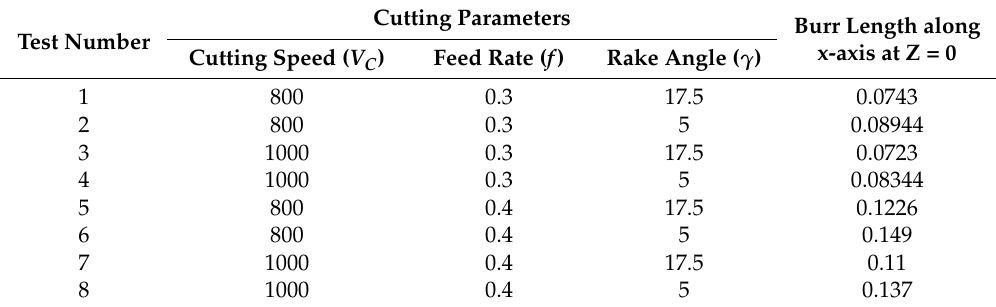
Table 4. Numerically computed end-burr lengths (mm) for various cutting